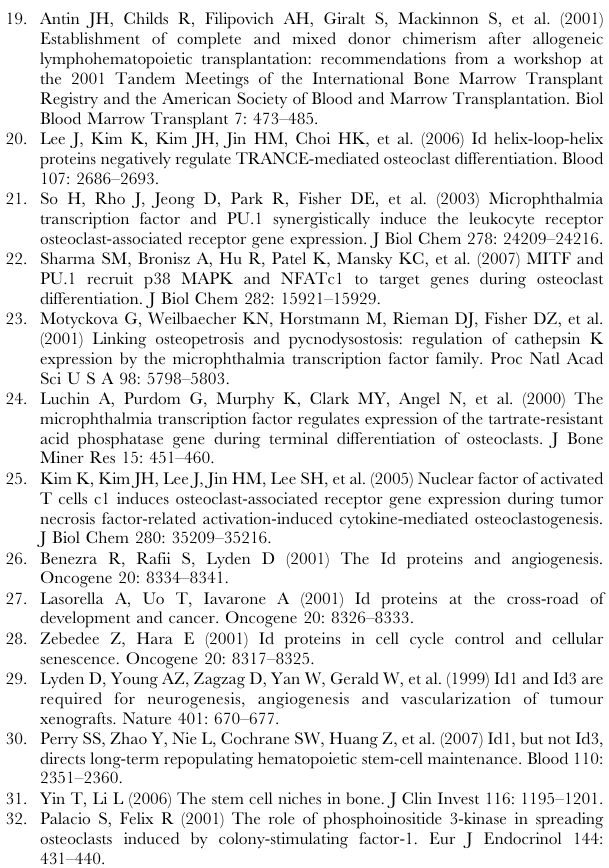
Figure S7 Use of lentiviral vectors to knockdown expression of CTSK. (A) Expression of CTSK in the BM of transplanted mice (***P , 0.001; n =6). Lin- BM cells from Id1 2 / 2 mice were transduced with lentivirus containing shCTSK or shGFP vector overnight and transplanted into lethally irradiated Id1 2 / 2 mice. was collected for qPCR analysis. Error bars represent 6 S.E.M. (B)